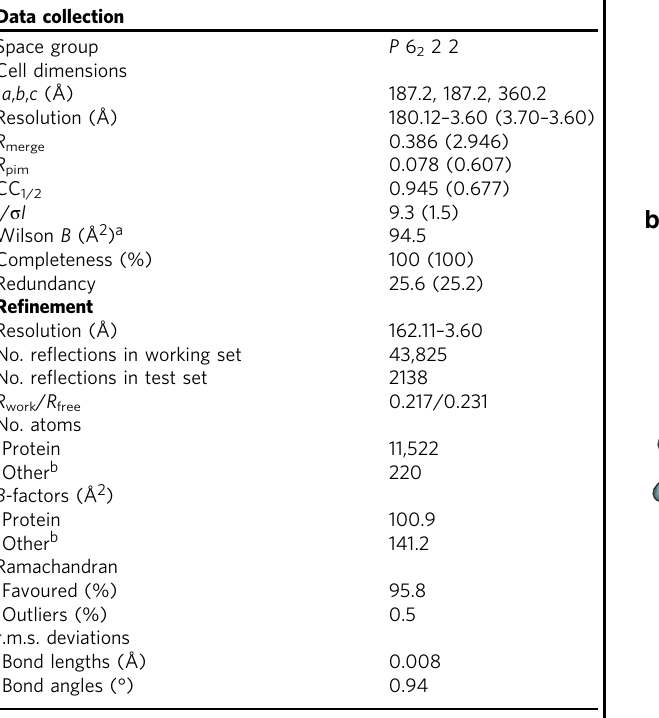
showing that the lipidated substrate GalCer (pink sticks) can fi t into this cavity, bridging the channel from the GALC active site to hydrophobic